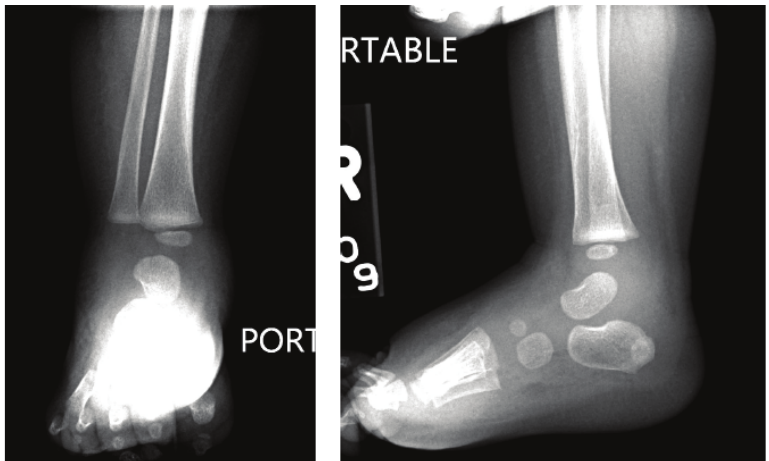
Figure 1: Radiograph of right ankle revealing moderate soft tissue swelling.